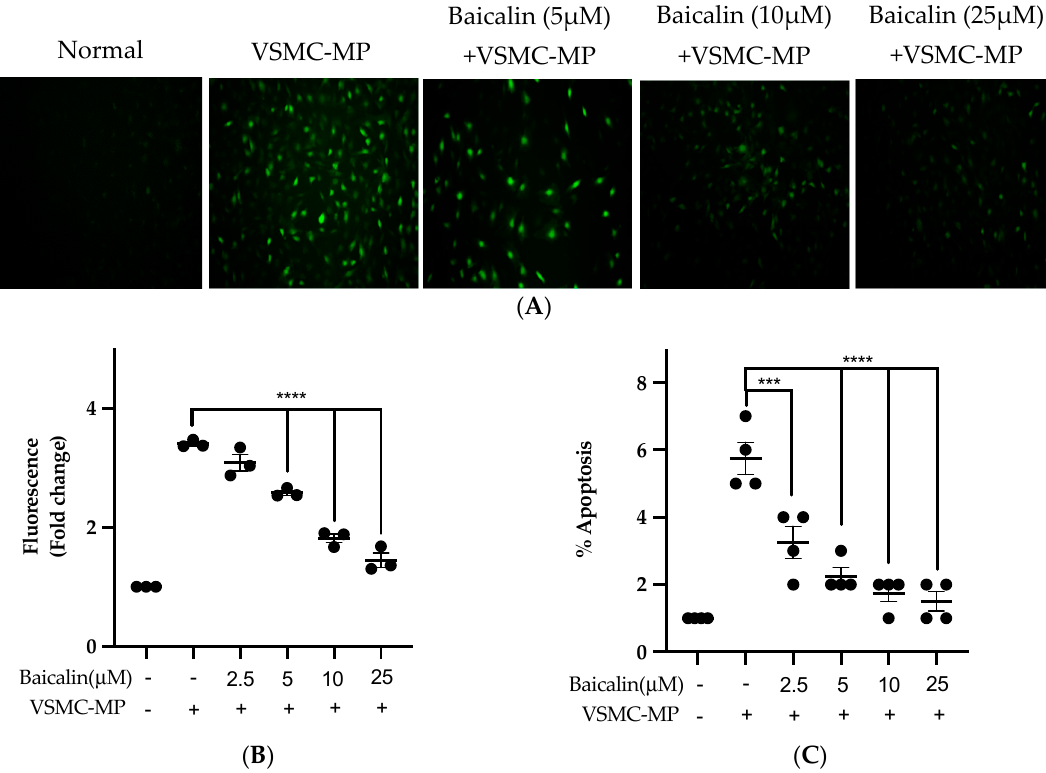
Figure 7. Effect of baicalin on ROS production and apoptosis of VSMC induced by VSMC-MP. ( A ) VSMC was treated with VSMC-MP and various doses of baicalin for 24 h. DCF-DA was treated to detect the ROS produce by VSMC indicated by green fluorescence. Image was taken at 20X magnification. ( B ) ROS fluorescence intensity was measured at excitation 485 nm and emission 527 nm. ( C ) VSMC treated with or without VSMC-MP and various doses of baicalin was incubated with Annexin V-FITC followed by propodium iodide. Analysis of VSMC apoptosis was completed with Arthur TM image-based cell analyzer. Each value is the mean ± SE of three to four independent experiments, and each independent experiment contains five replicates. *** p < 0.001, **** p < 0.0001 vs. control (VSMC -MP alone). The analysis was performed using one-way ANOVA followed by Dunnett multiple comparison test.